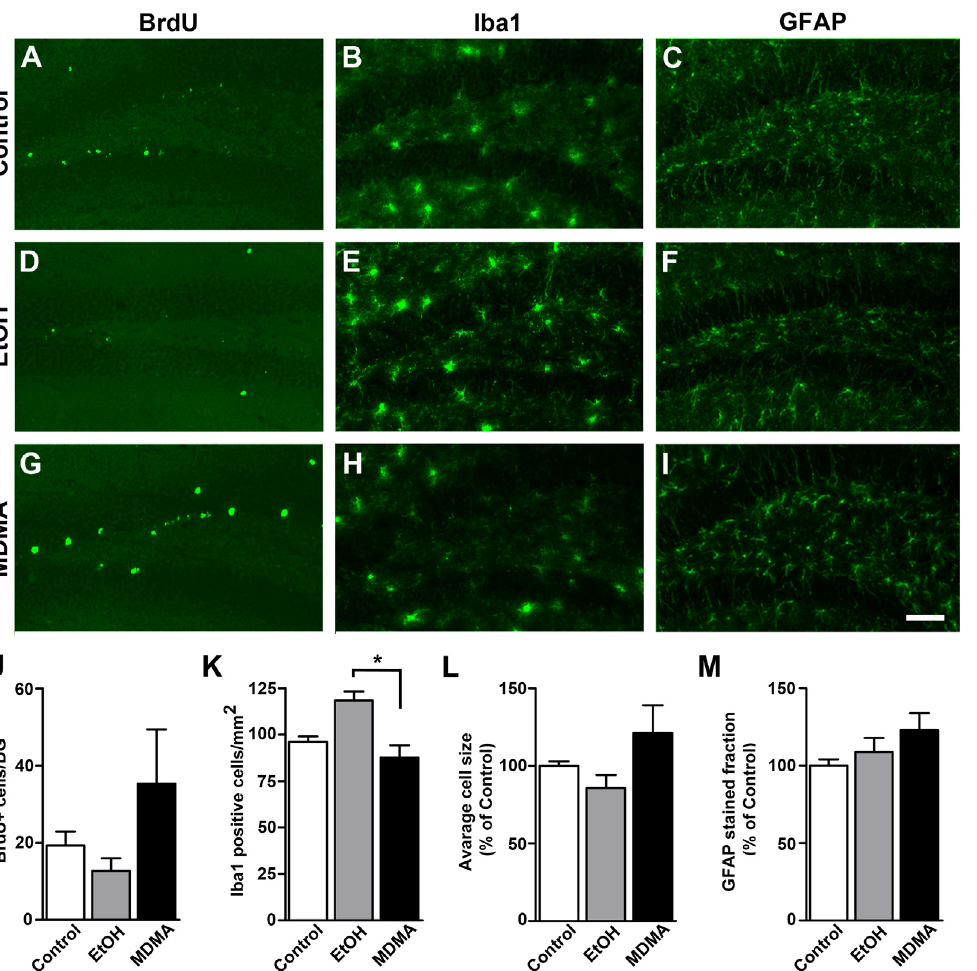
Fig 2. Effect of voluntary EtOH intake and high-dose MDMA (20 mg/kg x 2) on neuronal progenitor cells survival and glial cell activation in the hippocampus. Representative images show ( A,D,G ) BrdU-labeled, ( B,E,H ) Iba1-labeled and ( C,F,I ) GFAP labeled cells in the granule cell layer of the dentate gyrus. ( J ) Quantitative analysis of BrdU-labeled cells. Quantitative analysis of ( K,L ) Iba1-positive and ( M ) GFAP-positive cells from the dorsal and ventral hippocampus. Images were taken from coronal sections of the hippocampus of animals sacrificed 4 days after drug consumption. Data shown are the mean ± SEM (n = 4 mice/group). Statistically significant differences are represented by, * p < 0.0347; Tukey ’ s post hoc test. BrdU, Bromo-deoxyuridine; GFAP, glial fibrillary acidic protein; Iba-1, ionized calcium binding adaptor molecule 1; MDMA, 3,4-Methylenedioxymethamphetamine. Scale bar = 50 μ m.